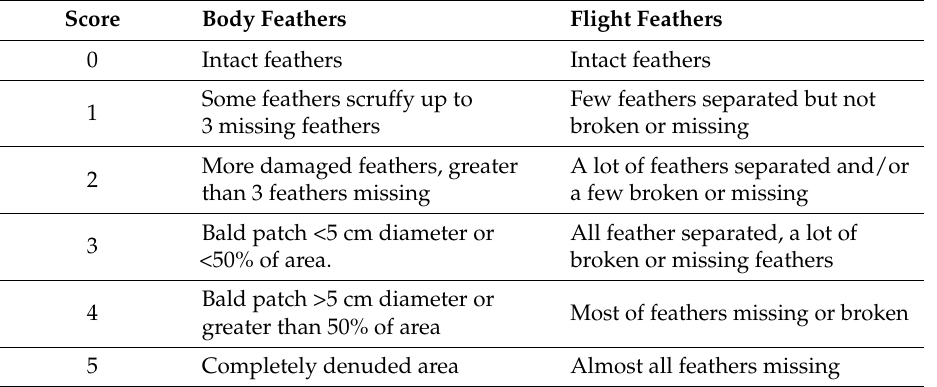
Table 2. Description of feather scoring method used to evaluate feather condition of the hens (adapted from Bilcik and Keeling,